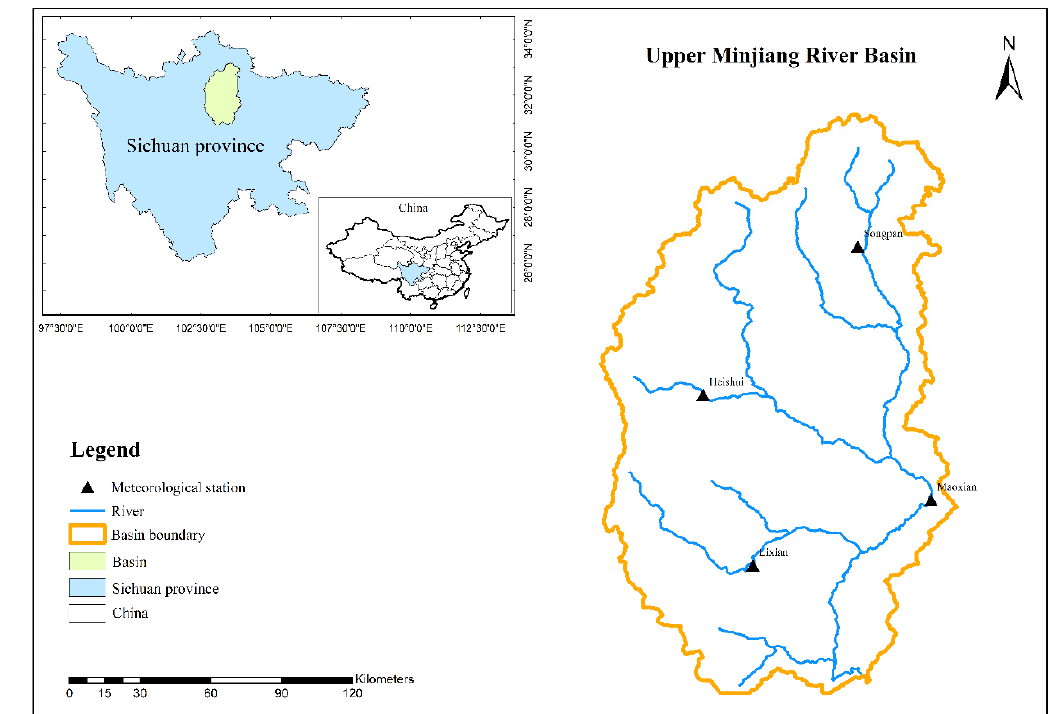
Figure 1. The location of the study area and meteorological stations.